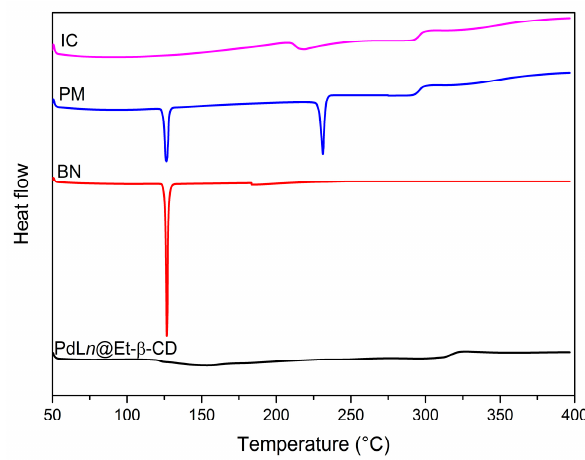
Figure 9. DSC of ( a ) PdLn@Et ‐β‐ CD, ( b ) 1 ‐ bromo ‐ 4 ‐ nitrobenzene (BN), ( c ) their physical mixture (PM), and ( d ) inclusion complex (IC).